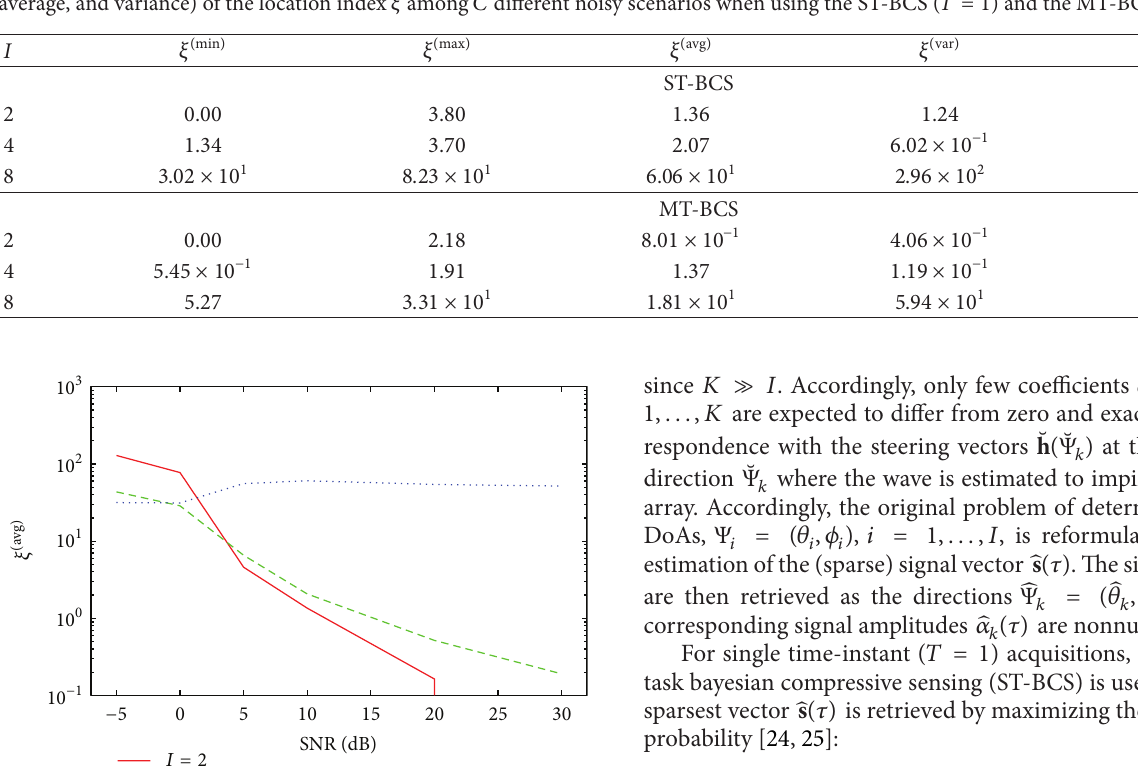
Table 3: Fully populated array—( 𝑁 = 25 ; 𝑑 𝑥 = 𝑑 𝑦 = 0.5𝜆 ; 𝐼 ∈ [2 : 8] ; SNR = 10 dB; 𝑇 = {1,2} ; 𝐶 = 50 )—statistics (minimum, maximum, average, and variance) of the location index 𝜉 among 𝐶 different noisy scenarios when using the ST-BCS ( 𝑇 = 1 ) and the MT-BCS ( 𝑇 = 2 ).